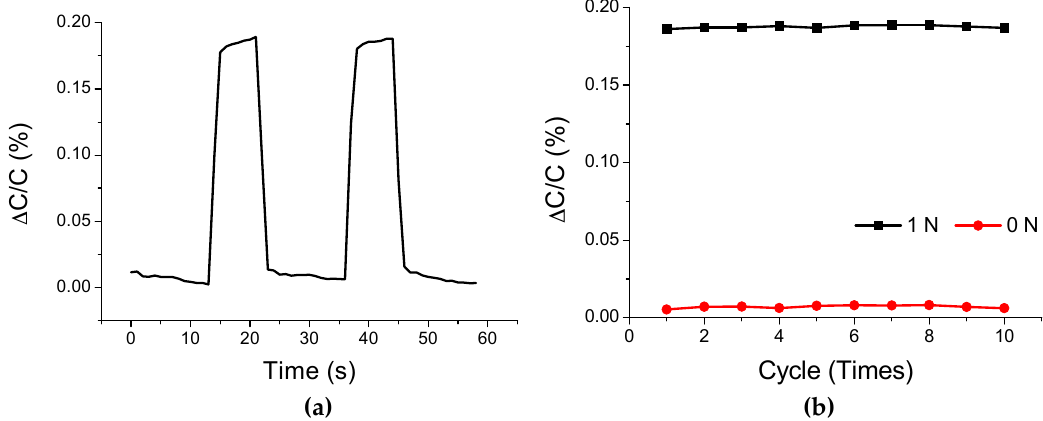
Figure 12. Capacitance change of the air-gap touch sensor during the repeated application of force: ( a ) switching of the input force; and ( b ) result of 10 time repetition of the switching process. At the first cycle, the average ∆ C / C was 0.1861% when the force of 1 N was applied, and 0.0054% when the force was released. At the tenth cycle, the average ∆ C / C was 0.1869% when the same force was applied and was 0.0062% when the force was released. These results show that the difference in ∆ C / C between the first and tenth cycles is negligibly small, which implies that the capacitance characteristic of the sensor samples can be maintained after the repeated application of